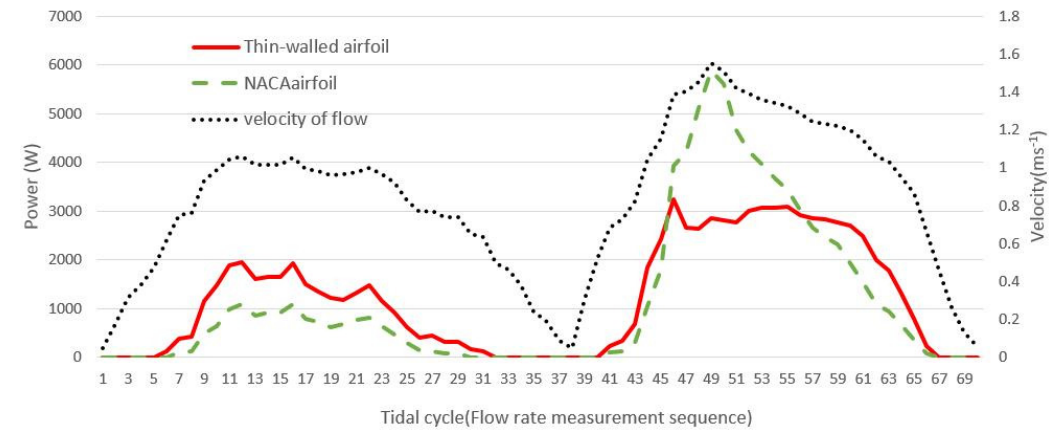
Figure 11. Periodic power and velocity diagram of tidal current.